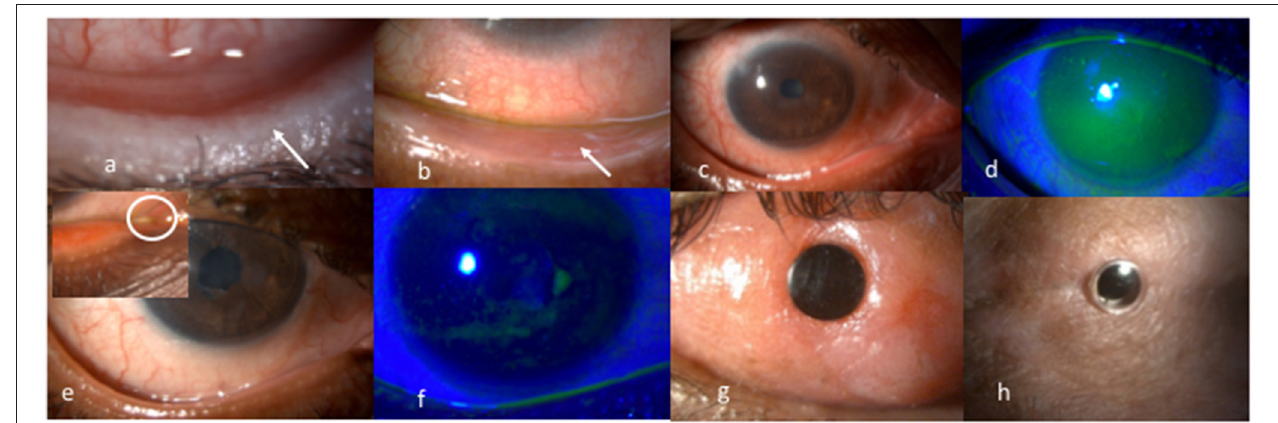
FIGURE 2 | (a) Lower lid margin keratinization causing a sand paper effect on the ocular surface due to blink related microtrauma. (b) Post mucous membrane grafting for lid margin keratinization showing a smooth lid margin maintained at years following surgery. (c,d) Inflamed ocular surface with diffuse superficial punctate keratopathy on corneal fluorescein staining pre punctal cautery. (e,f) Resolution of surface inflammation and punctate keratopathy post punctal cautery improving patient’s symptoms of photophobia and foreign body sensation. (g) 15 years post modified osteo odonto keratoprosthesis maintaining a best corrected visual acuity of 20/20. (h) 5 years post Boston type 2 keratoprosthesis maintaining best achieved corrected visual acuity of 20/30.